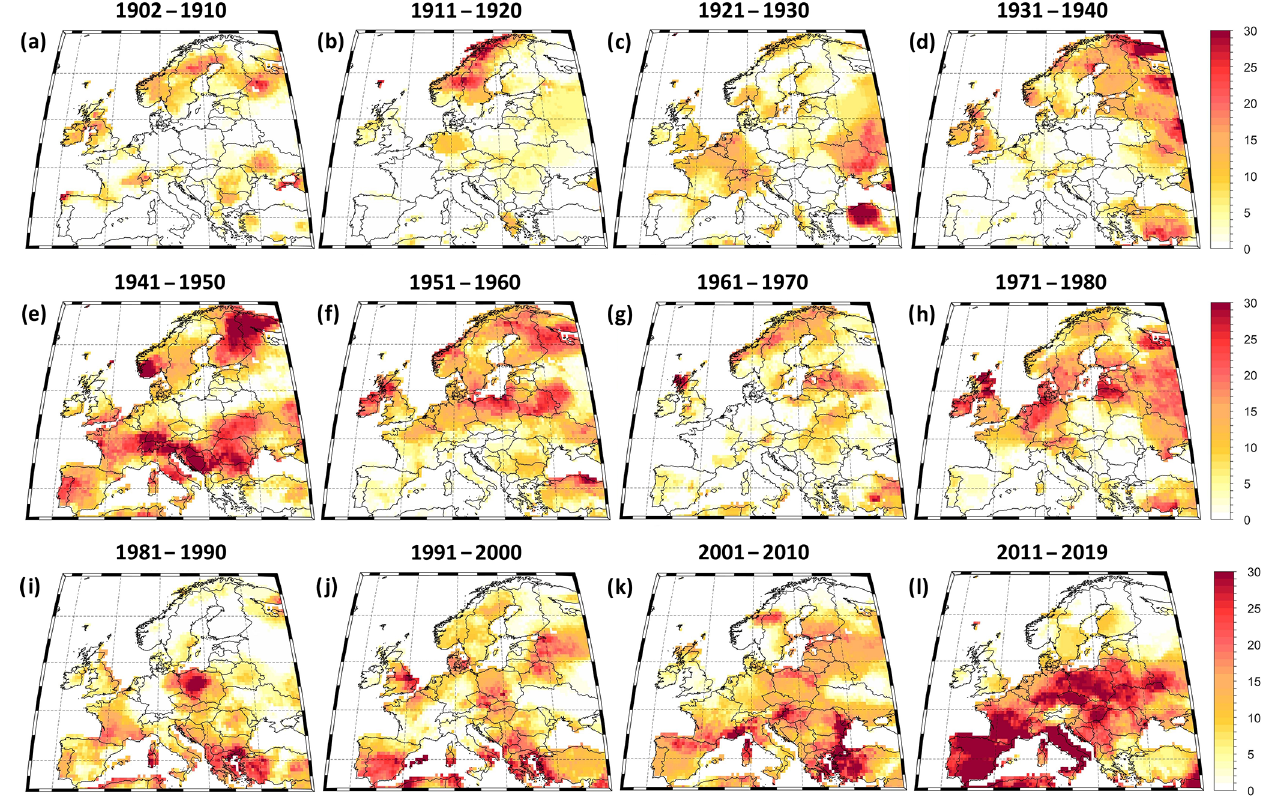
Figure 6. Decadal frequency of drought duration for severe drought (SPEI12 between − 1 . 51 and − 2). (a) 1902–1901, (b)